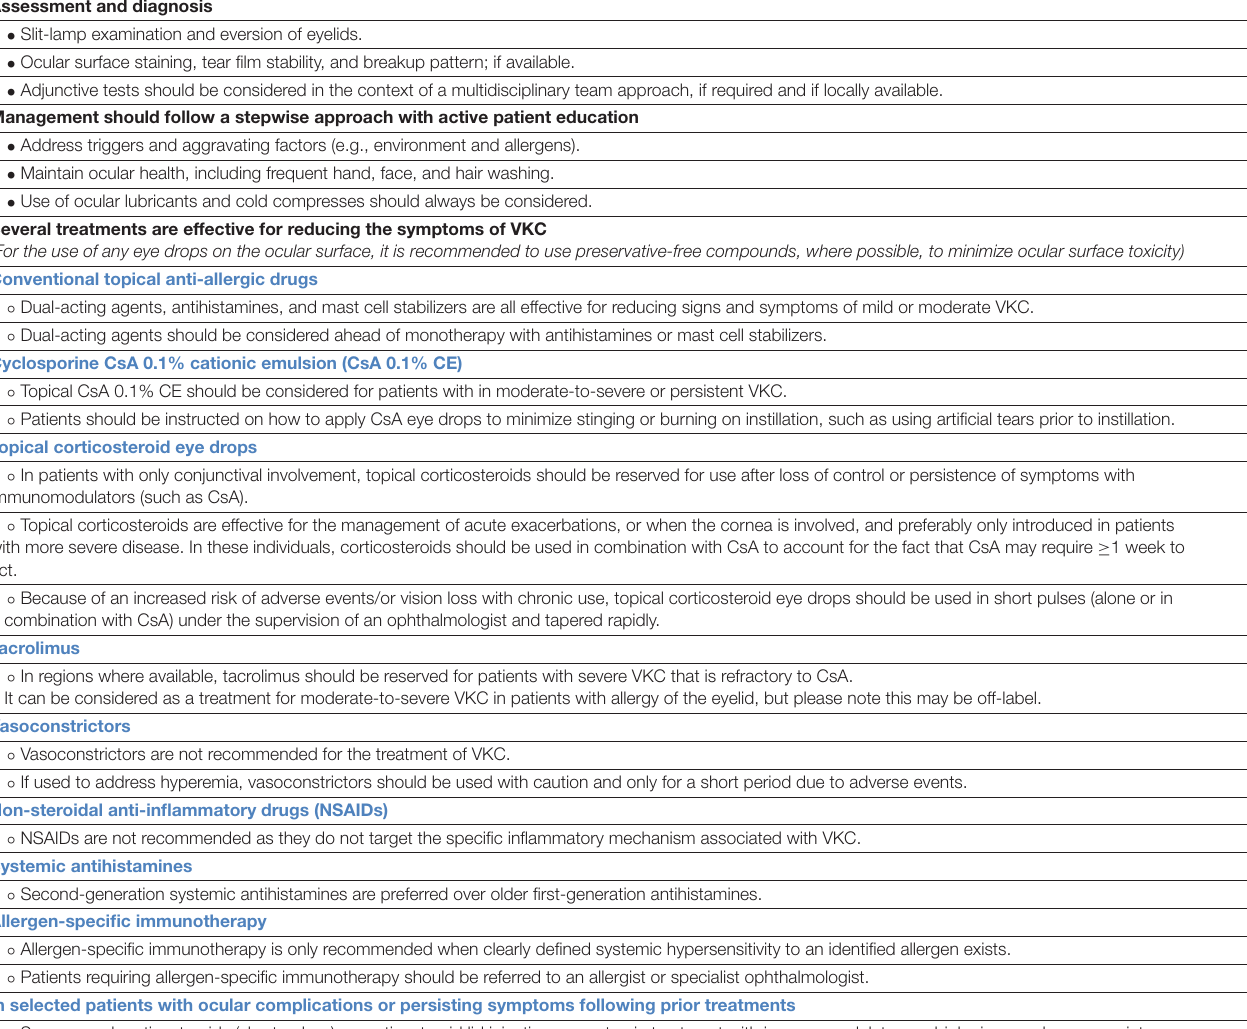
TABLE 1 | Expert-led recommendations from the MOVIA Expert Working